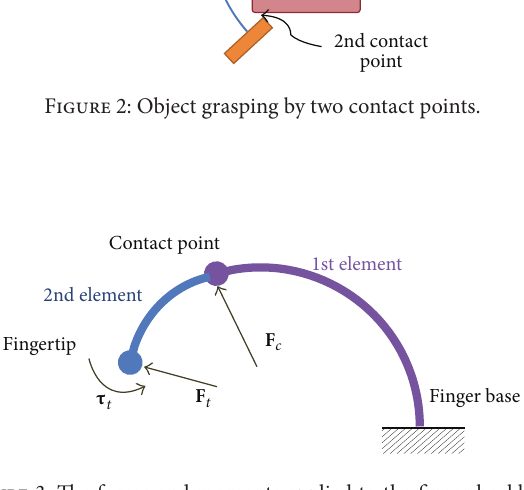
Figure 3: The forces and moments applied to the finger backbone and the two circular elements.